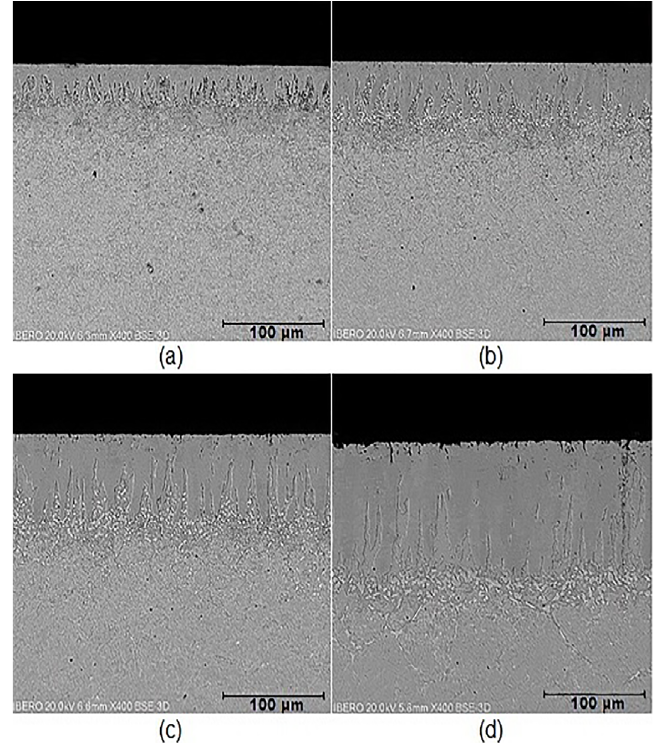
Figure 5. SEM micrographs of the cross-sections of AISI S1 steels borided with exposure time of 4 h, during different boriding temperatures: (a) 1123 K, (b) 1173 K, (c) 1223 K and (d) 1273